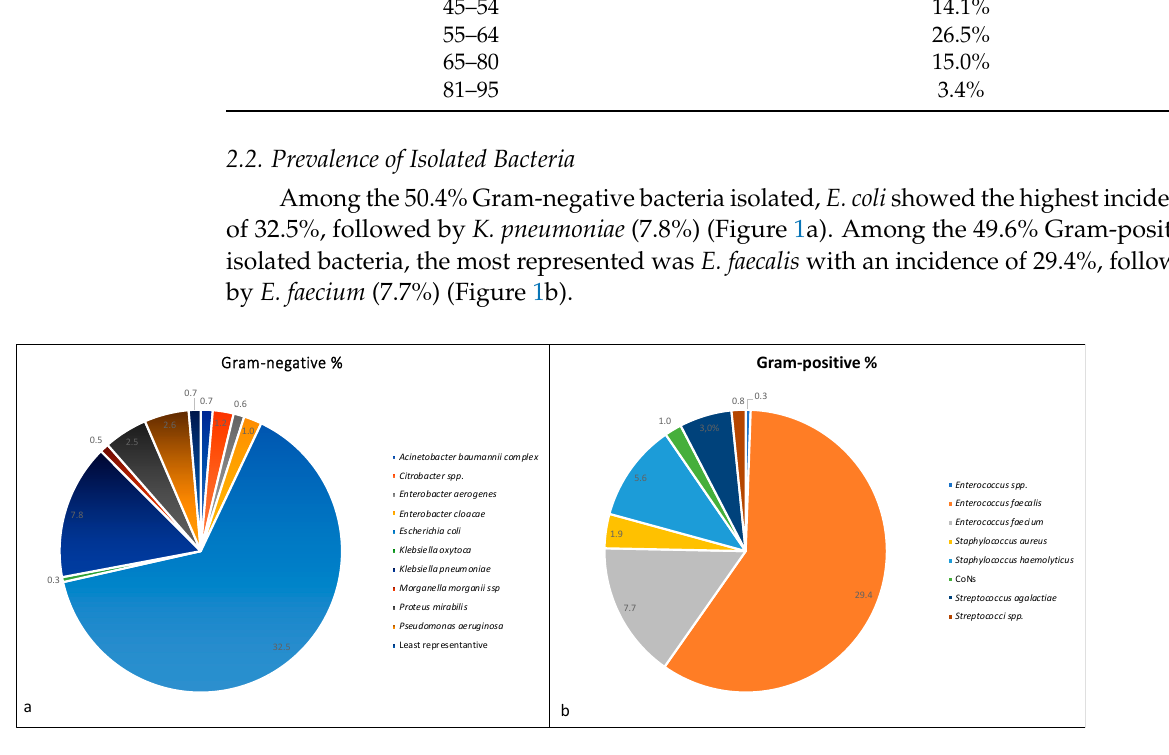
Figure 1. Percentage of ( a ) Gram-negative and ( b ) Gram-positive bacteria found in positive vaginal swabs. In ( a ) “least representative” signifies strains isolated only one time during the five years, so these strains were merged together into one category. In ( b ) CoNs represents coagulase-negative staphylococci.